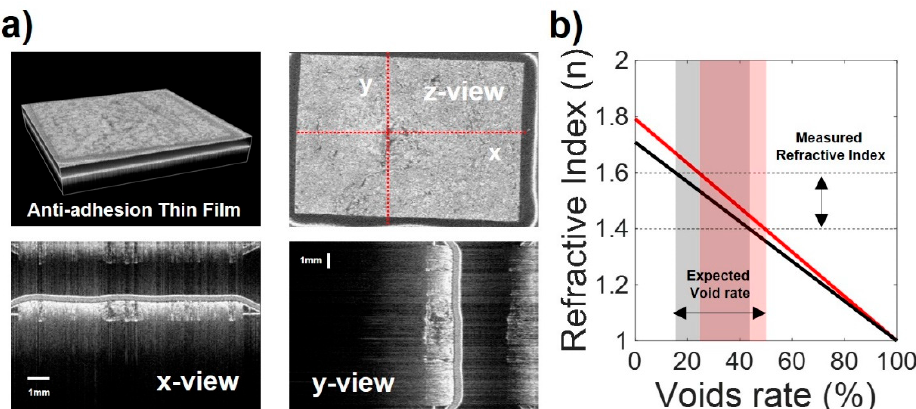
Figure 5. ( a ) Optical coherence tomography (OCT) images of the thin anti-adhesion film. ( b ) Graph of the measured refractive index and void ratio of the thin film. The light red region represents the void ratio of the film calculated from the refractive index of the cross-linked film ( n = 1.791). The light black region represents the void ratio of the film from the refractive index of the noncross-linked film ( n = 1.708).